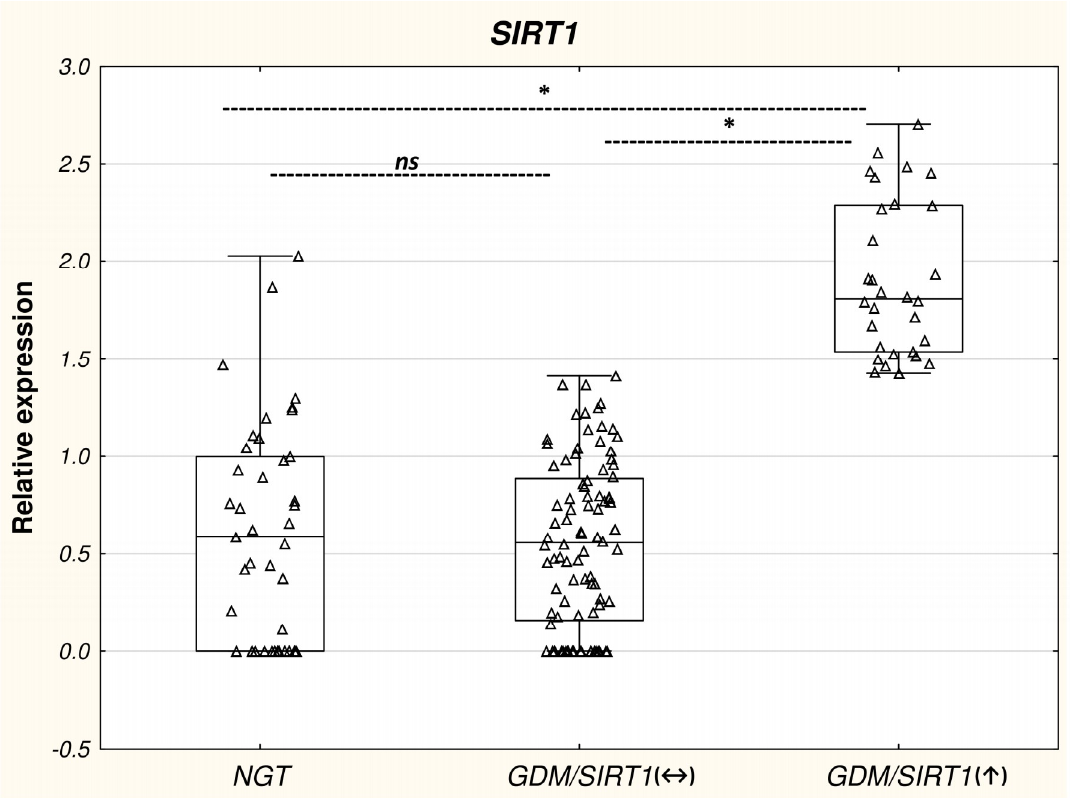
Figure 1. Comparison of leukocyte SIRT1 mRNA expression in the NGT ( n = 41), GDM/ SIRT1 ( ↑ ) ( n = 30) and GDM/ SIRT1 ( ↔ ) ( n = 92) groups. Leukocyte SIRT1 mRNA level was normalized to a mean of the endogenous control GAPDH . Data are expressed as median ± interquartile range (25–75%), * p < 0.05 as assessed by post hoc test for pairwise multiple comparisons of mean rank sums; n.s.: non-significant.